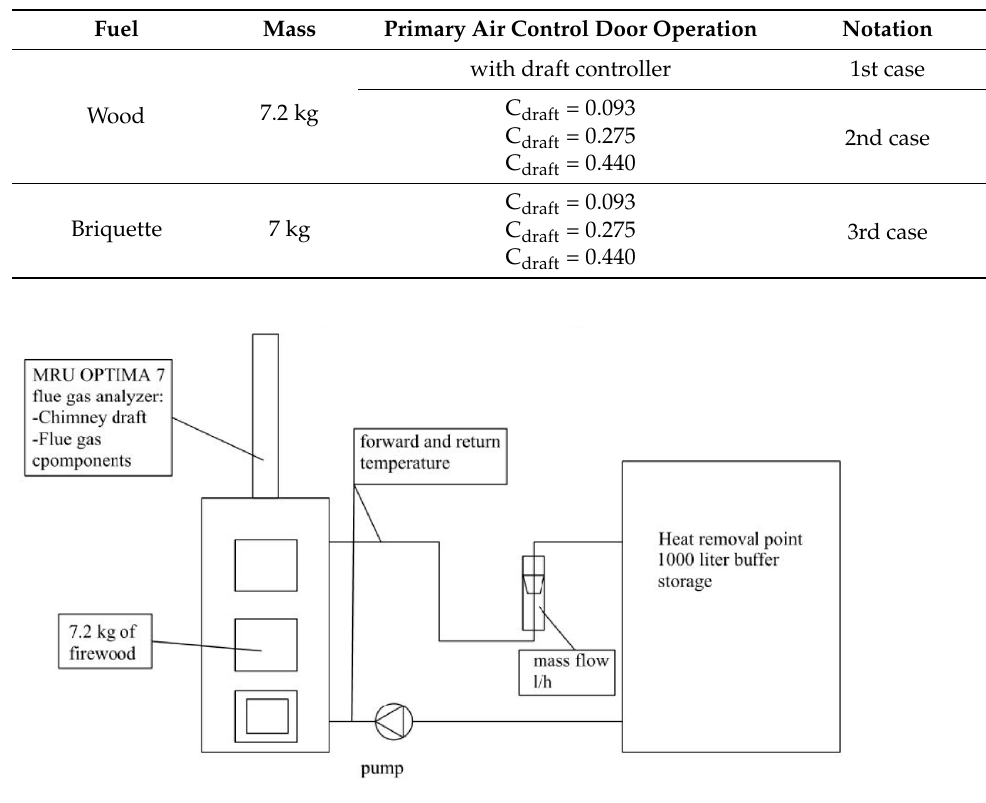
Figure 4. Development of Q at different flow rates over the whole period.